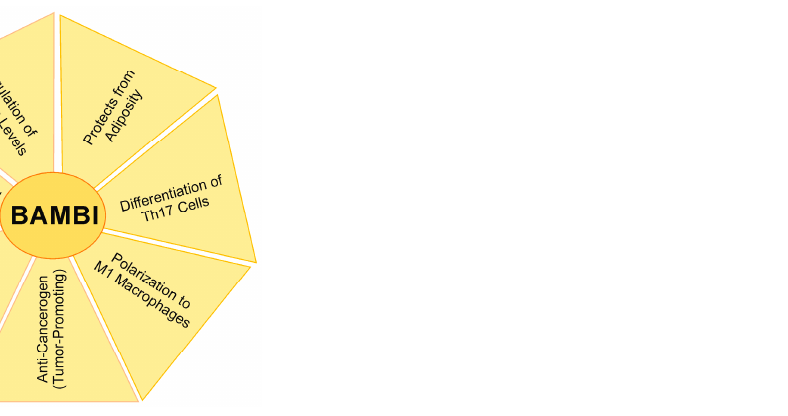
Figure 8. Processes regulated by BAMBI overexpression. The anti-fibrotic effects of BAMBI in the liver have been best studied so far. Whether all of the other functions of BAMBI have a role in liver diseases is unclear. Kupffer cells do, for example, not express BAMBI, and further studies are needed to clarify the effect of BAMBI overexpression in these different